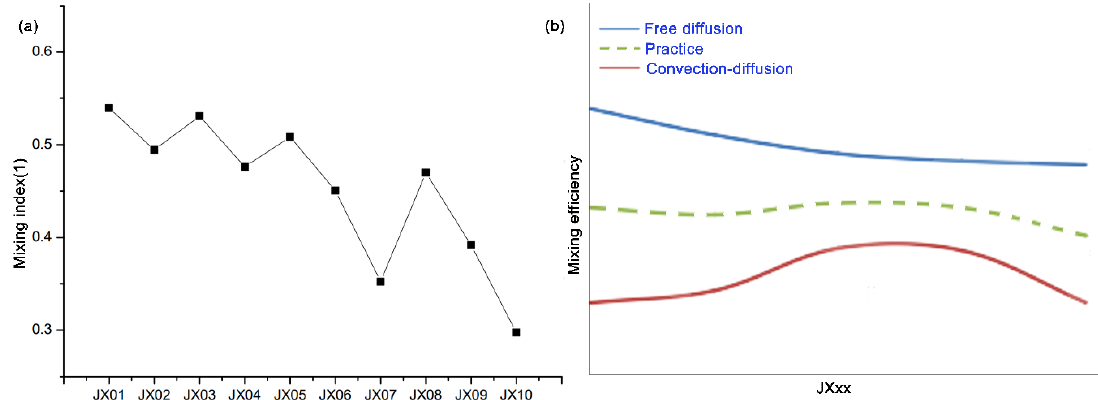
Figure 9. Mixing index and diffusion types in the reacting pipe: ( a ) mixing index of the micro reacting pipe with different determining size; ( b ) interaction of free diffusion and convection diffusion.